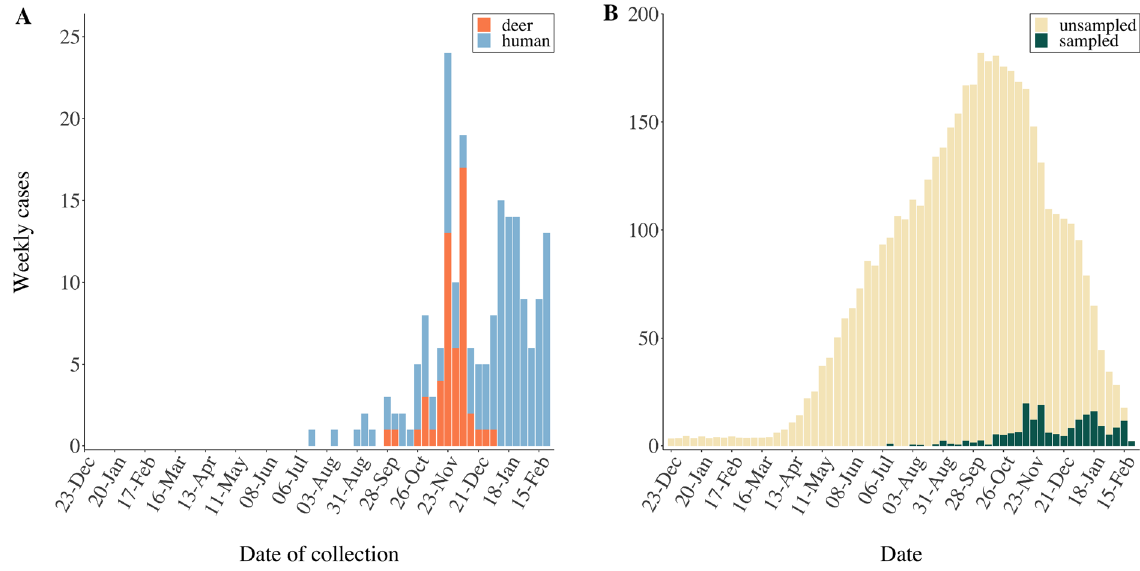
Figure 1. ( A ) Number of deer (orange) and human (blue) SARS-CoV-2 cases sampled per week between 22 July 2020 and 28 February 2021. ( B ) Mean inferred number of unsampled (beige) and sampled (green) cases in the transmission tree over time.